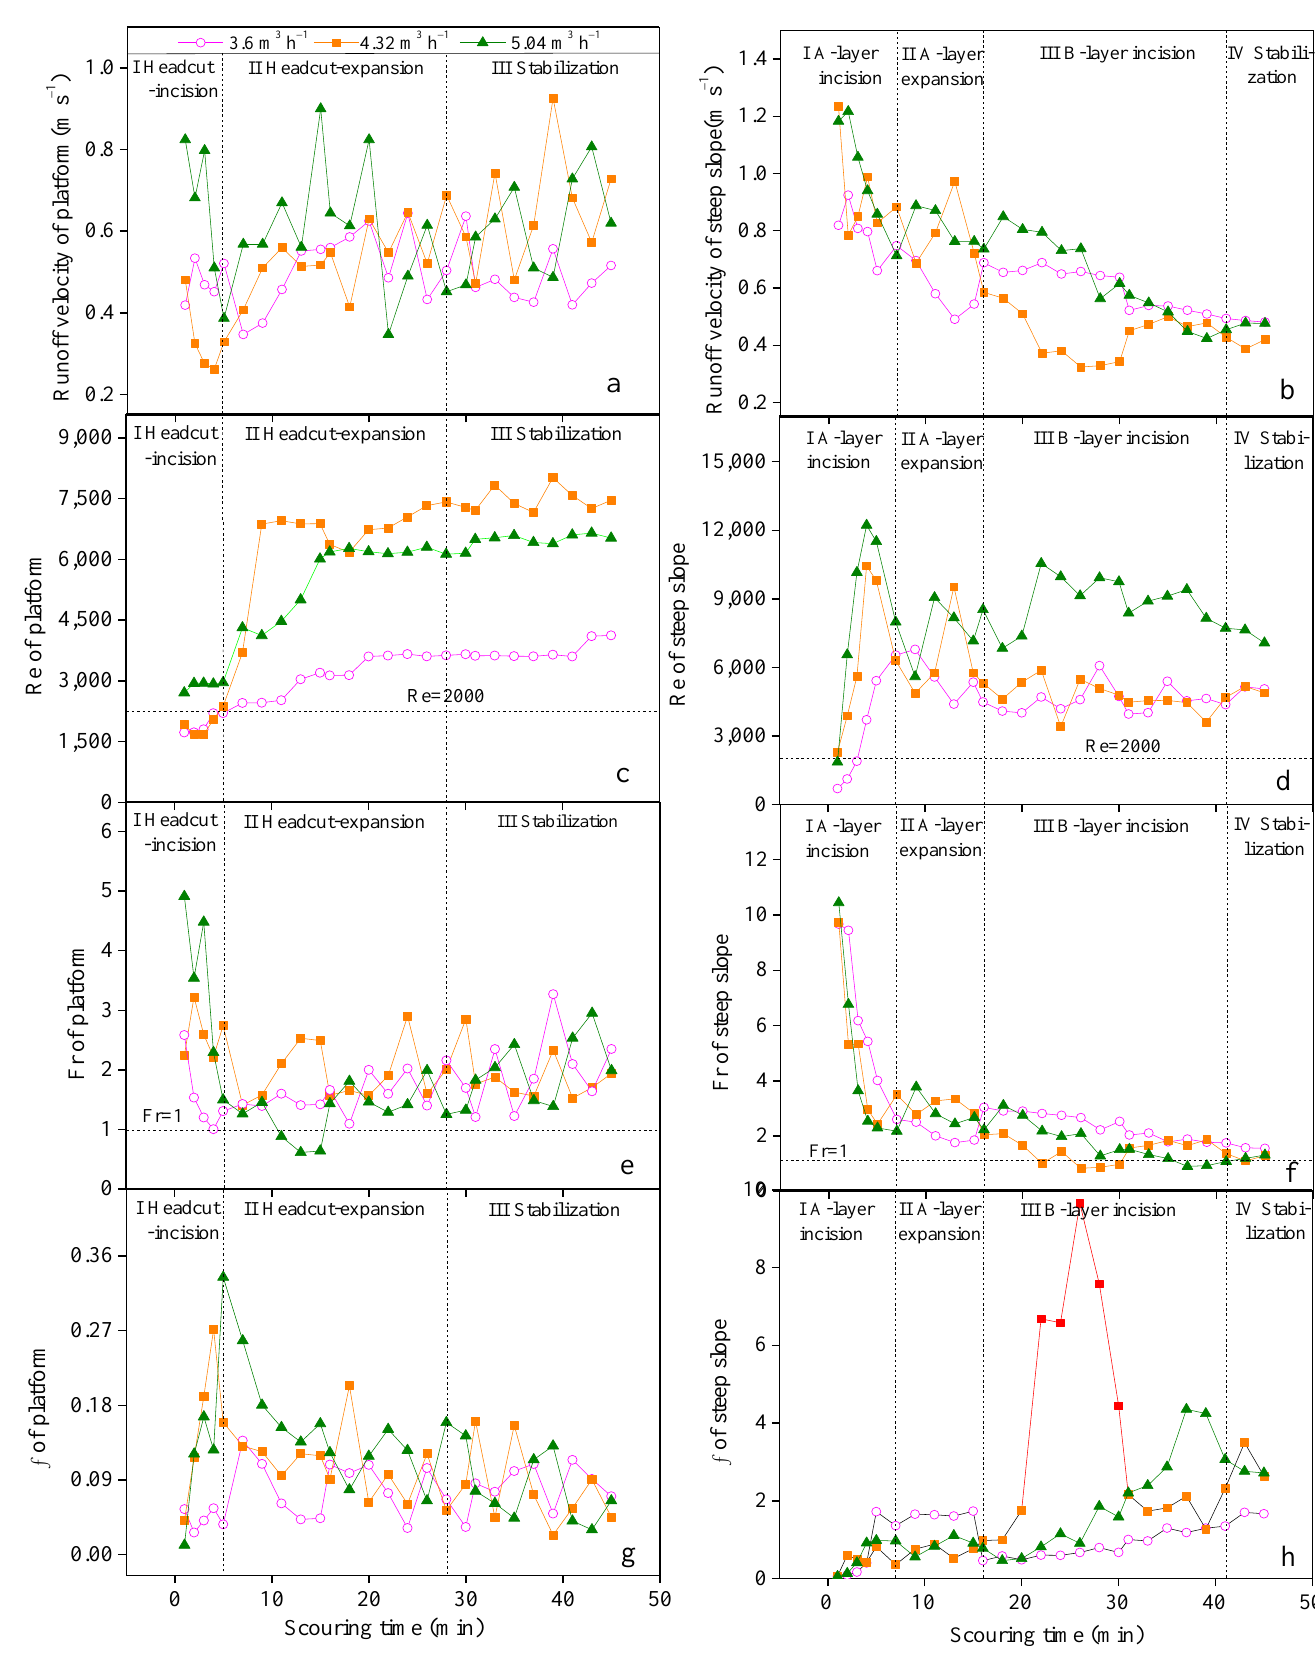
Figure 5. Temporal variations in flow hydraulics. Note: The red point represents the abnormal point of the hydrodynamic parameters after the collapse of gully sidewalls.